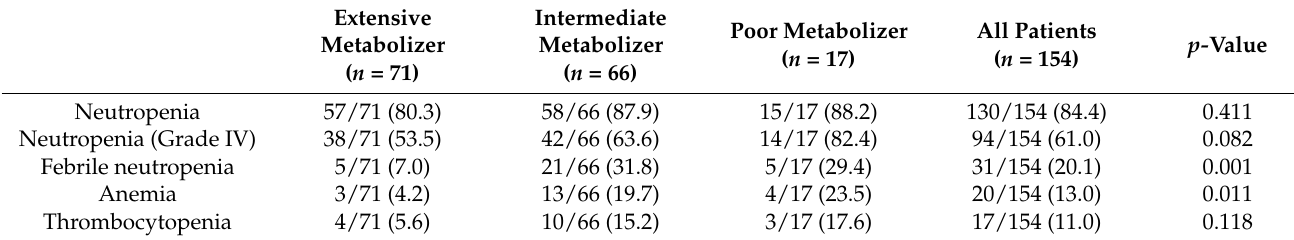
Table 7. Serious hematologic toxicity (Grade III/IV) according to UGT1A1 phenotype.